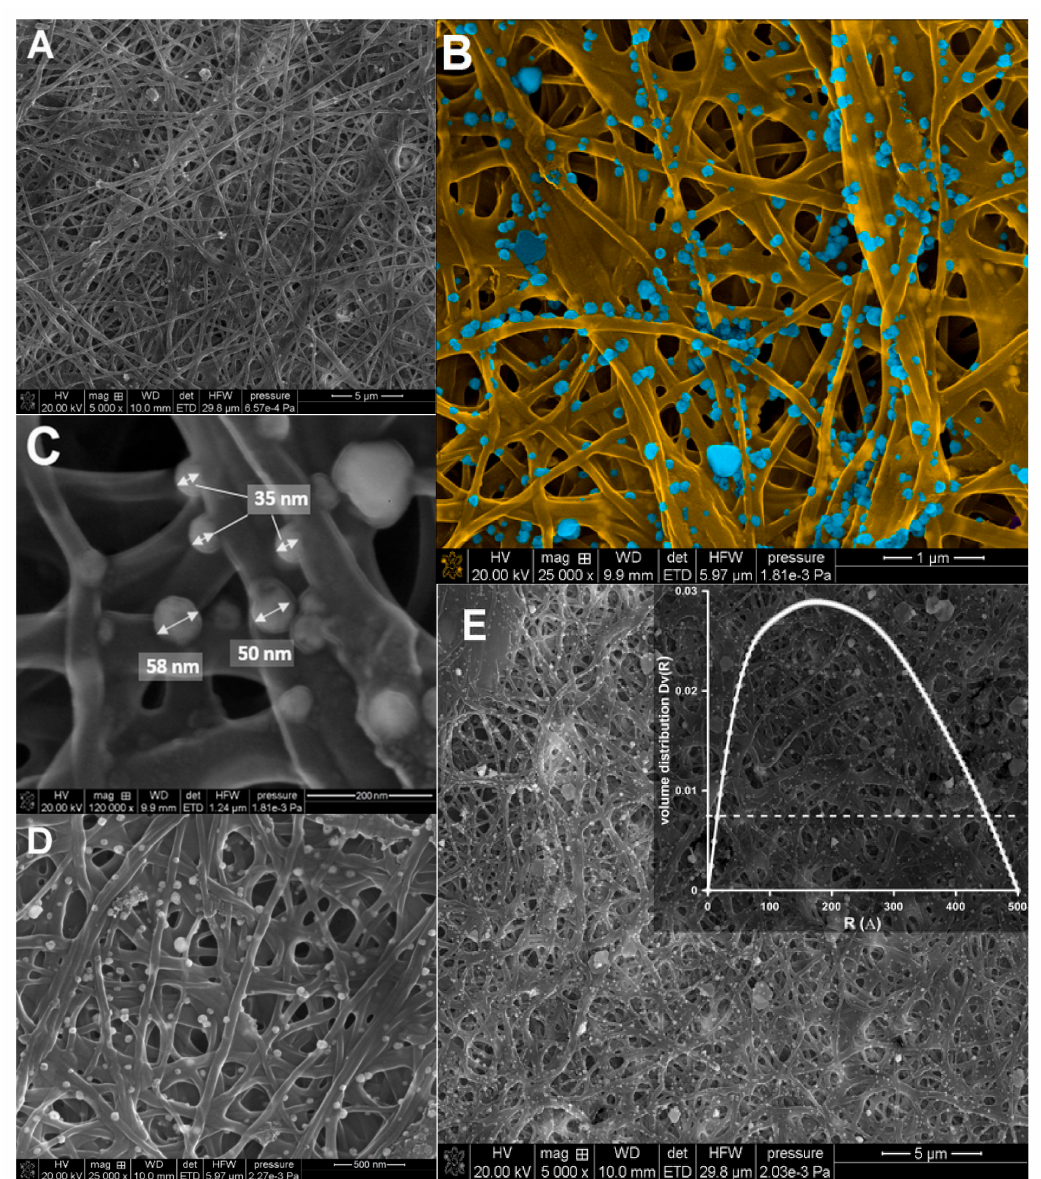
Figure 7. RepresentativeSEMimagesoftheelectrospunnanofibers. ( A )SEMimageofCS / silica(CS / SBA-15), ( B – E ) SEM images of Ag / CS / SBA-15 at various magnifications. Note: The insert in Figure 4E shows the radial distribution function, Dv(R), obtained from the SAXS data for Ag / CS /